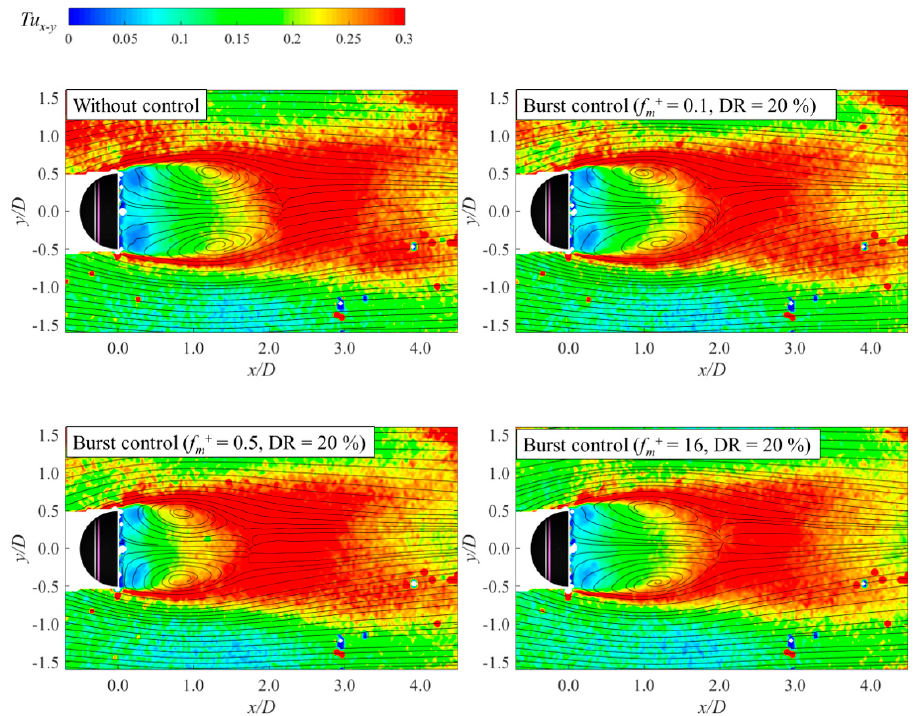
Figure 14. Turbulent intensity distributions in the x – y cross section ( z / D = − 0.5).